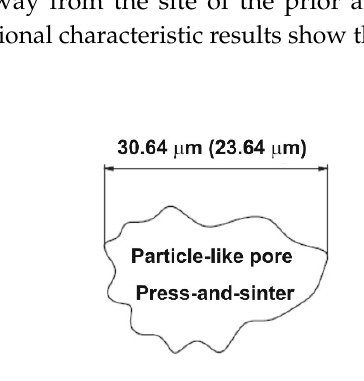
Figure 7. Particle-like pore derived from press-and-sinter process.